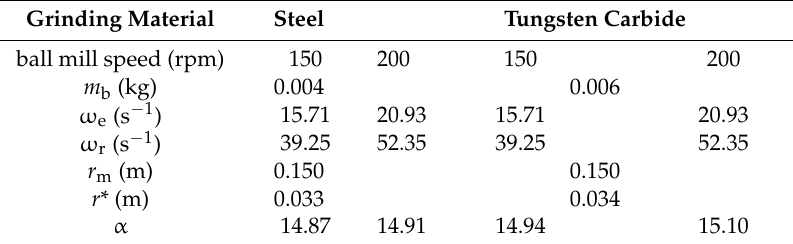
Table 2. Parameters for the calculation of v c and E kin